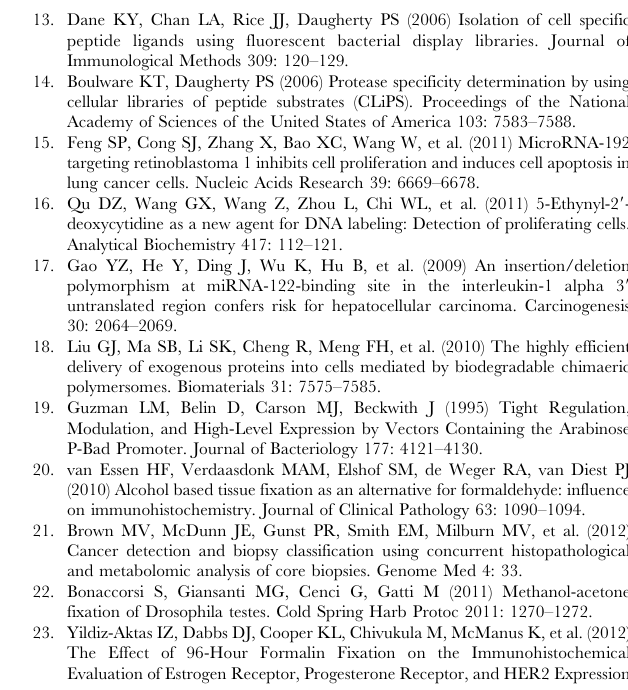
Figure S1 FACS results of various cells binding with fixed monoclonal peptide-fluorescent bacteria at ratio 1:500.